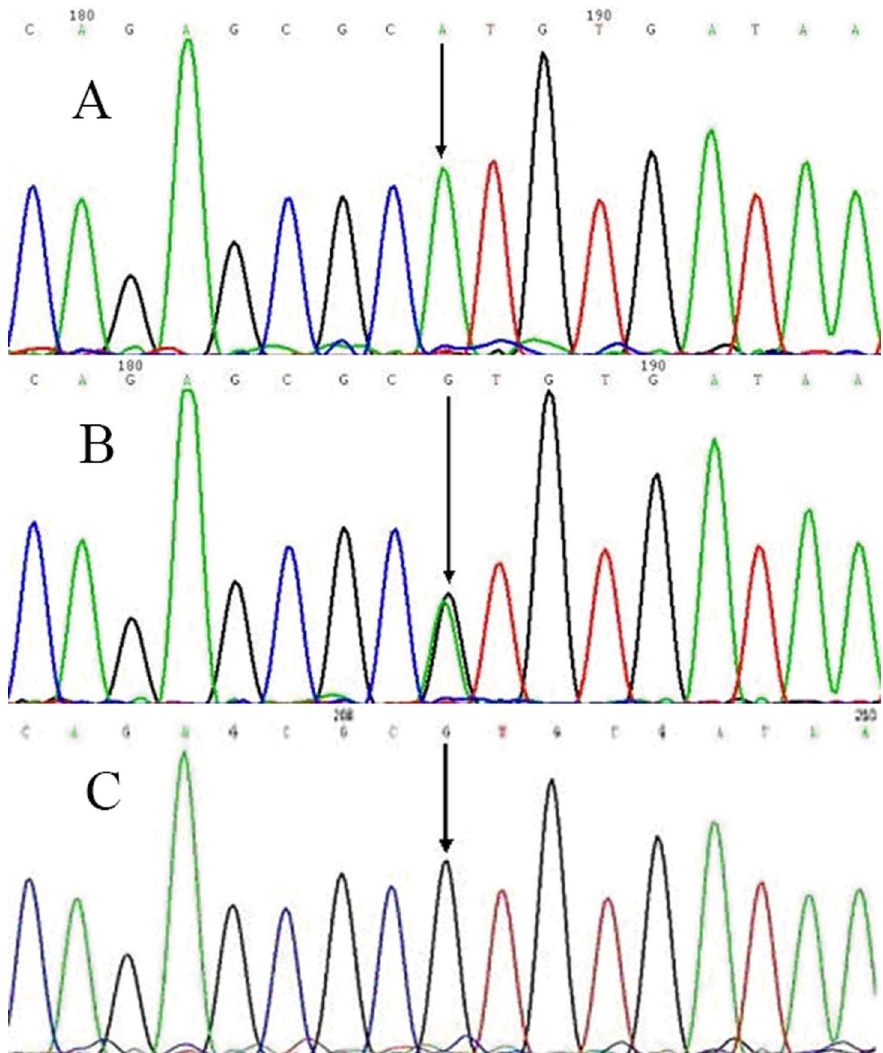
Figure 4. Sequenced diagrams of the PCR amplification production of the rs4769874. (A) A unimodal arrowed was homozygous AA. (B) GA bimodal arrowed was heterozygous GA. (C) G unimodal arrowed was homozygous